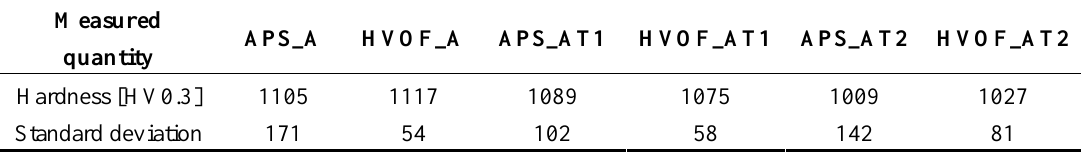
Table 4. Vickers hardness values (HV0.3) and standard deviations of the